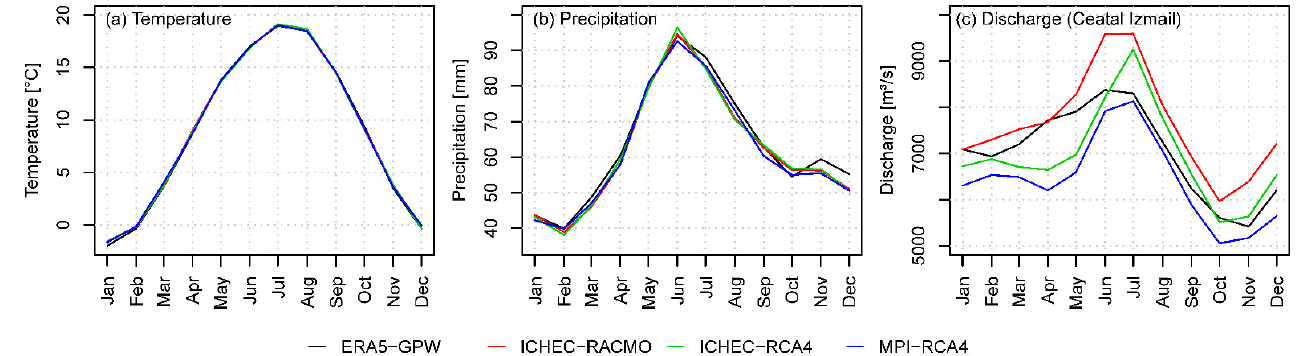
Figure 2. Hindcast of long-term mean monthly temperature [°C] ( a ) and precipitation [mm] ( b ) (1980–2000) on spatial average over the Danube River Basin as well as long-term mean monthly discharge [m 3 /s] ( c ) at outlet gauge Ceatal Izmail (1980–2000). The simulations driven by the bias-corrected GCM-RCM ensemble members ICHEC-RACMO, ICHEC-RCA4 and MPI-RCA4 were compared with the ERA5-GPW-driven simulation of Probst and Mauser [23].